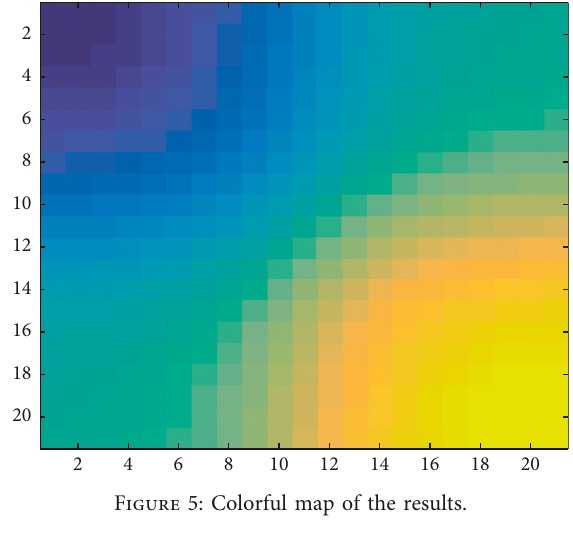
Figure 5: Colorful map of the results.